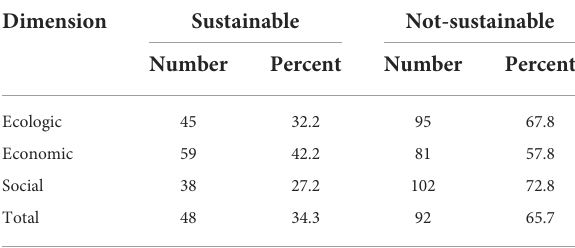
TABLE 6 The status of agricultural sustainability of local